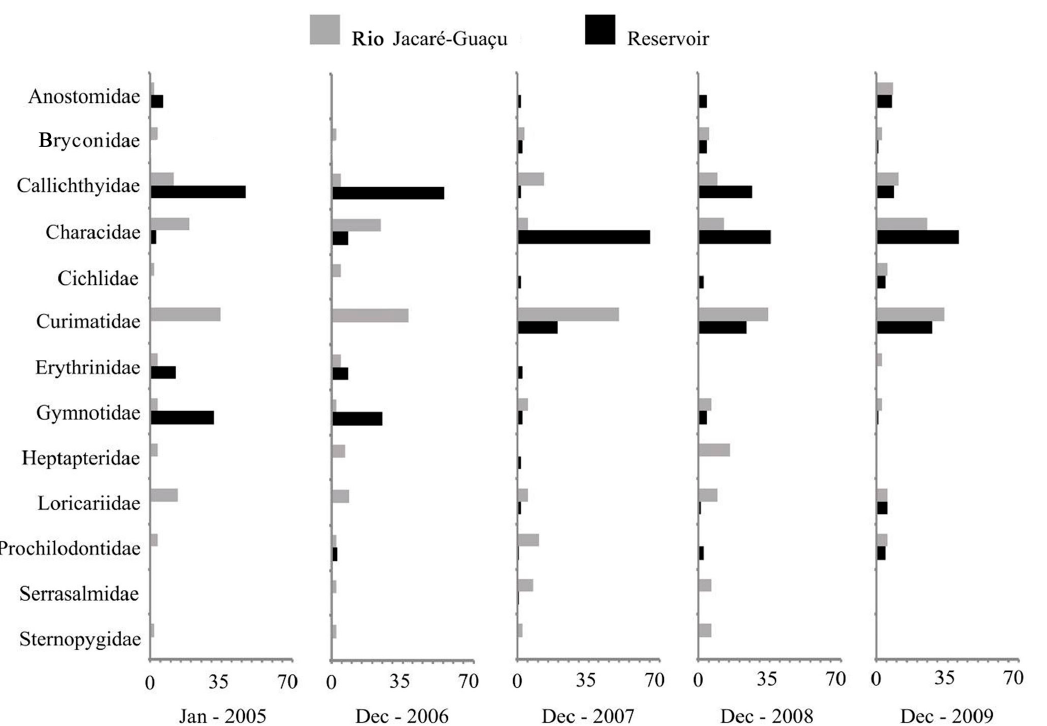
Figure 3. Representativeness, in percentage of the number of specimens, of the fish Families captured in the Gavião Peixoto Reservoir before and after the dredging and management of